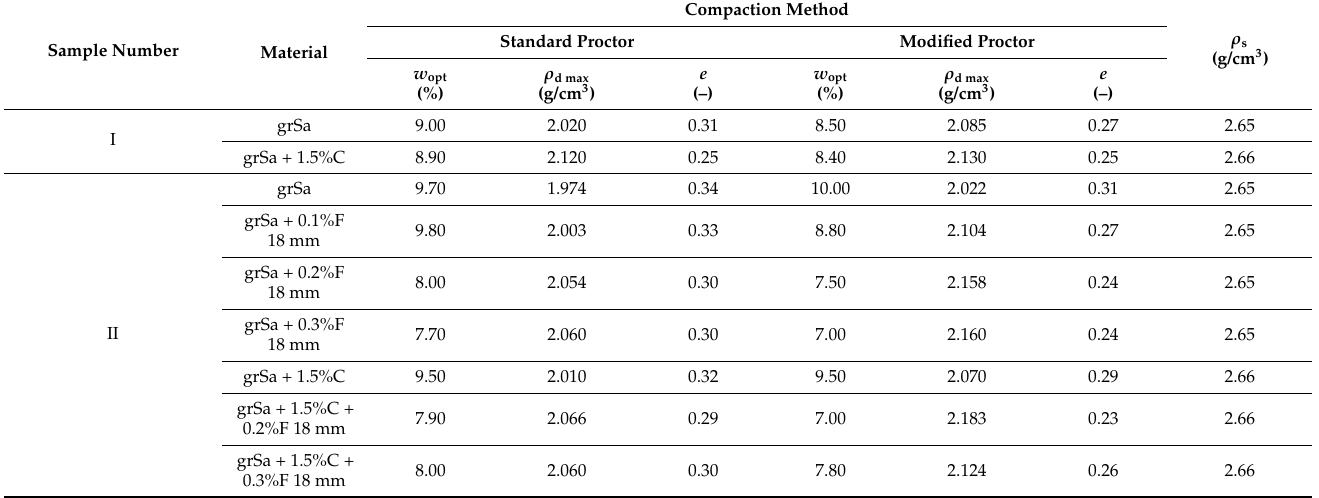
Table 1. Geotechnical properties of tested materials.